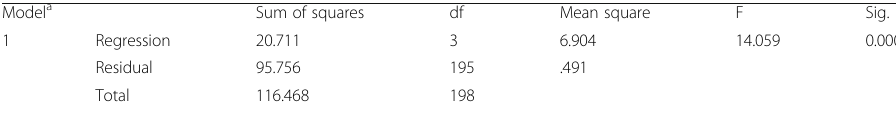
Table 4 ANOVA Model a Sum of squares df Mean square F Sig. Regression